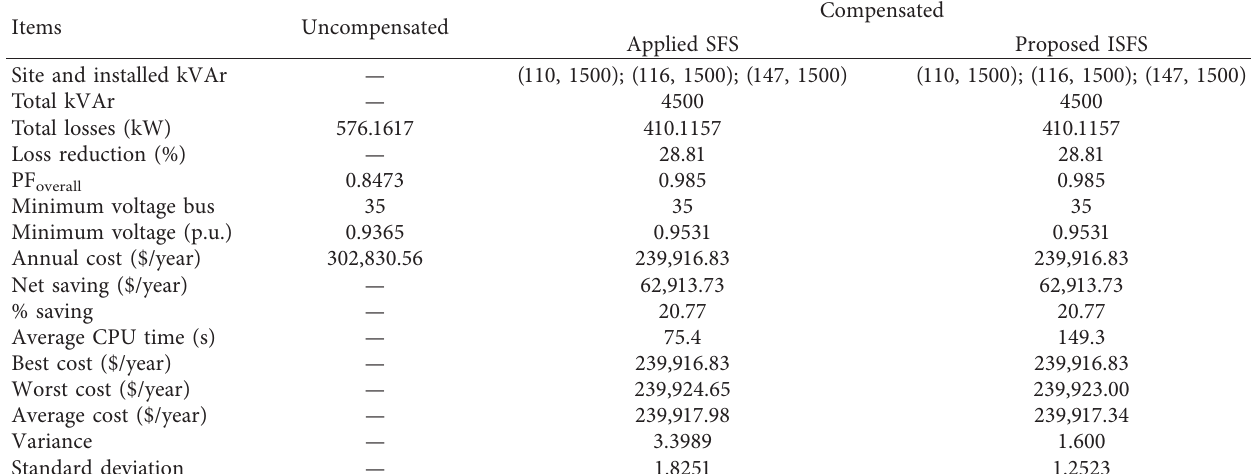
Table 12: Result comparison of ISFS and SFS for 119-bus network at 100% loading in scenario 1.